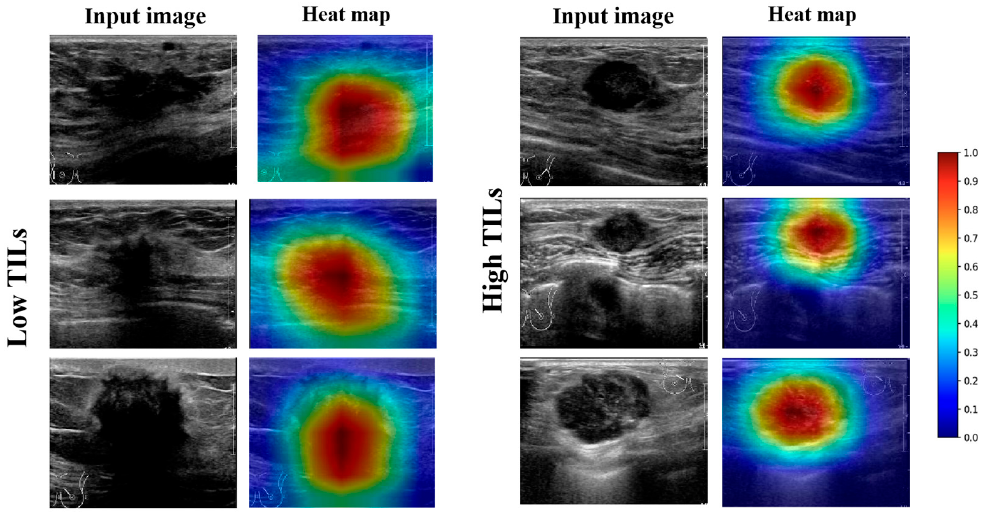
Figure 6. Examples of high-TIL-level and low-TIL-level tumors with B-mode US images and corre- sponding heat maps generated by CLA-HDM. The heat maps showed that the interior of the tumor is valuable for predicting high TIL levels, while the tumor interior and posterior predict low TIL levels. TILs, tumor-infiltrating lymphocytes.